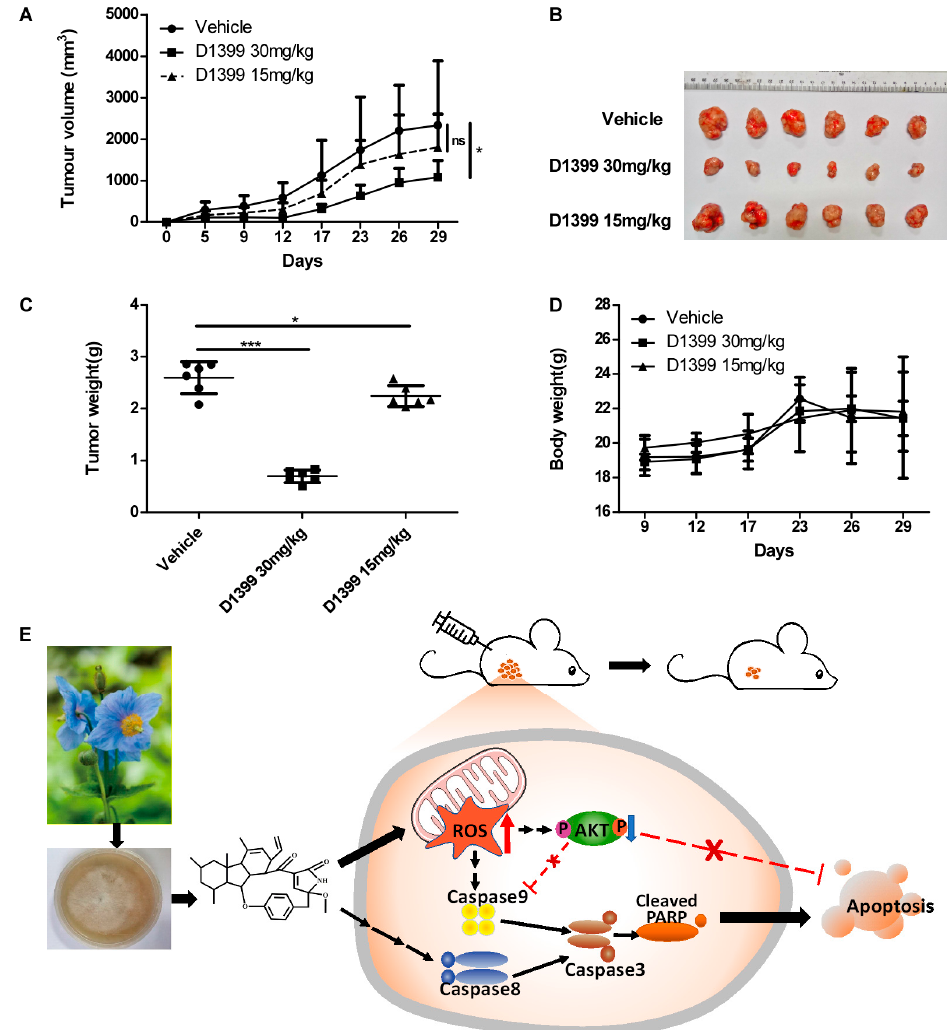
Figure 6. Antitumor effect of D1399 in vivo on xenografted H460 tumors in nude mice. Mice were inoculated with H460 cells (1 × 10 6 cells per mouse) in the right side of the axillary. When tumor volume reached 80–200 mm 3 , mice received intraperitoneal injection of D1399 (15 mg·kg − 1 and 30 mg·kg − 1 ) every three days, n = 6 mice per group. The statistical comparison vs. vehicle-treated control is shown by a t -test. * p < 0.05, *** p < 0.001, ns, Non-Significant. ( A ) The average volume and standard deviation were recorded and plotted; ( B ) The subcutaneous tumors formed by the H460 cells were dissected and imaged; ( C ) The tumor weights at the end of the experiment; ( D ) The body weight change curves of each group of mice; ( E ) A schematic diagram of the proposed mechanism of D1399 inducing cancer cell apoptosis through the ROS-AKT pathway. D1399 increases ROS generation and reduces the phosphorylation of AKT, thus inducing cell apoptosis via both caspase-8- and caspase-9-dependent apoptotic pathways. We hypothesized that D1399 induces the apoptosis of lung cancer cells on the extrinsic and intrinsic pathways by an ROS-dependent AKT signaling pathway.